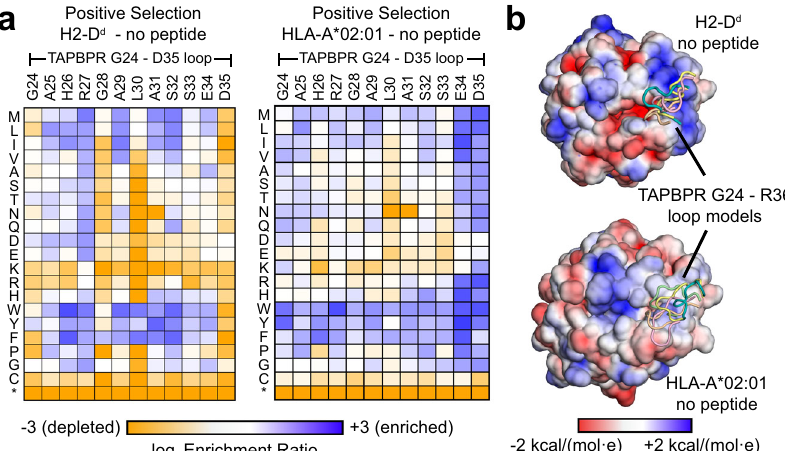
Fig. 3 TAPBPR 24 – 35 loop sequence interaction landscape is pMHC-I allele-dependent. a A TAPBPR library of substitution mutants in the 24 – 35 loop was displayed on the yeast surface and sorted for high binding signal to fl uorescent pMHC-I tetramers made using refolded P18-I10/H2-D d and TAX9/ HLA-A*02:01. In these experiments there was no excess of competing peptide; see Supplementary Fig. 3 for data from equivalent selections with competing free peptide. In the mutational landscapes, log 2 enrichment ratios for each mutation are plotted from ≤ − 3 (depleted/deleterious, orange) to ≥ + 3 (enriched, dark blue). TAPBPR 24 – 35 loop residue position is on the horizontal axis, and amino acid substitutions are on the vertical axis (*, stop codon). b Solvent-accessible surfaces of MHC-I molecules colored by electrostatic potential (negative in red, to positive in blue) as calculated in CHARMM-GUI PBEQ-Solver for H2-D d (PDB 3ECB) and HLA-A*02:01 (PDB 1DUZ). The fi ve lowest energy RosettaCM models of the TAPBPR 24 – 35 loop are shown as